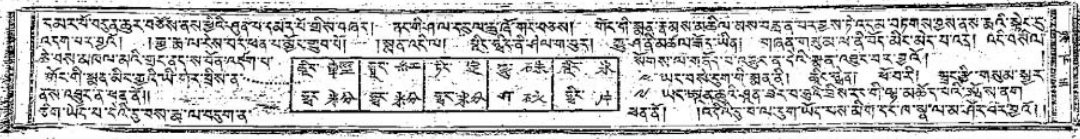
Figure 1. The Method to Prepare Oil based Basam Medicine and Five Elixir Medicinal Baths by Chakhar Géshé Lobsang Tsültim (1740–1810).